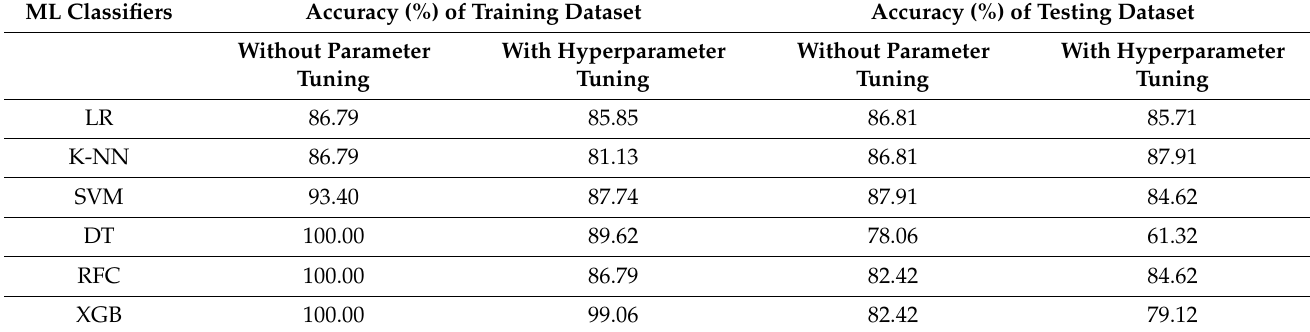
Table A3. Comparison of the accuracy of the training and testing datasets with and without tuned hyperparameters.